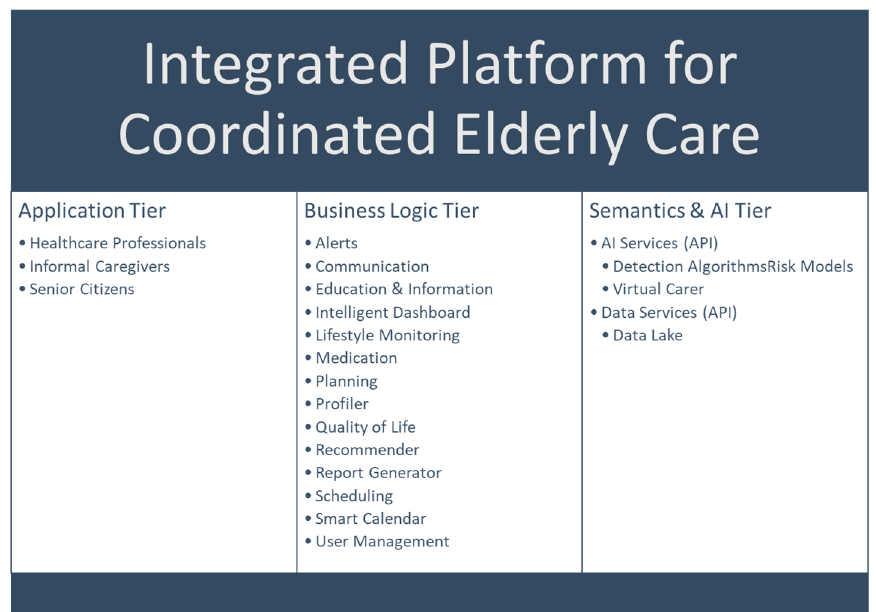
Figure 1. High-level depiction of the core components of the proposed solution. Security, integrity, and interoperability services are horizontal to all tiers. Interoperability Services in particular aim to link data originating from wearables such as smartwatches, EHRs such as those based on national infrastructures, sensors (e.g., for temperature measurement), medical devices, and other